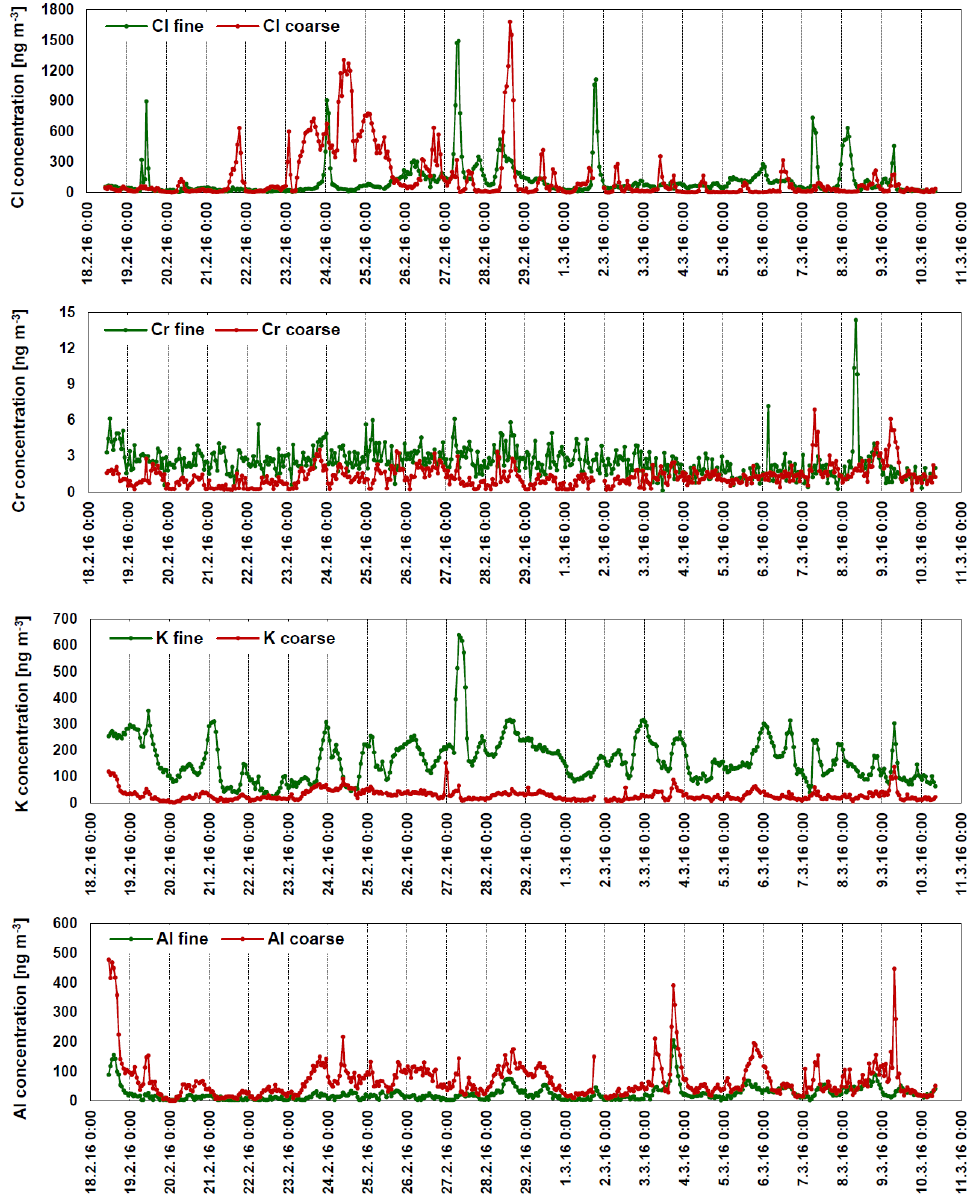
Figure 3. Hourly concentrations (ngm − 3 ) of Cl, Cr, K, and Al measured in the fine (green) and coarse (red)